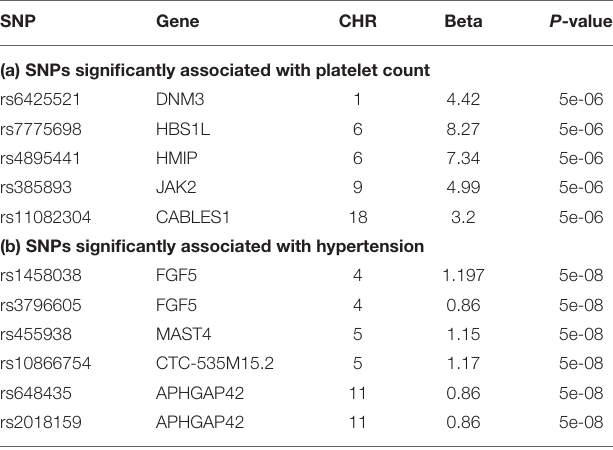
TABLE 4 | List of SNPs with genome-wide significance using Taiwan Biobank data. Gene CHR Beta